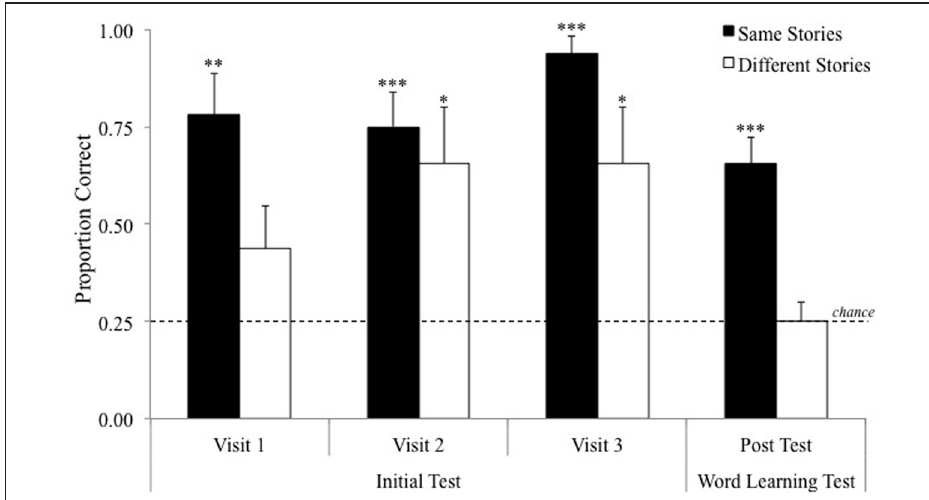
FIGURE 1 | Results from Horst et al. (2011a) at a glance. Dotted line represents chance (0.25). Error bars represent one standard error. ∗∗∗ p < 0 . 001, ∗∗ p < 0 . 01, and ∗ p < 0 . 05. All p s are